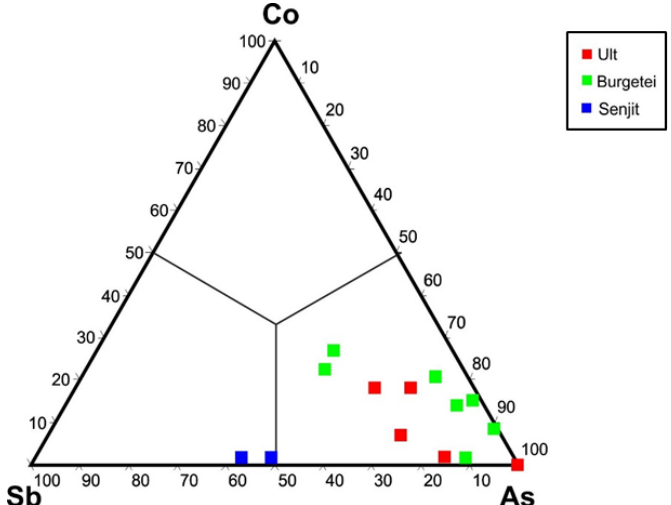
Figure 7. Compositions of the metasomatic alteration rocks at the three gold occurrences of the Uyanga ore district as a triangle diagram showing indicative